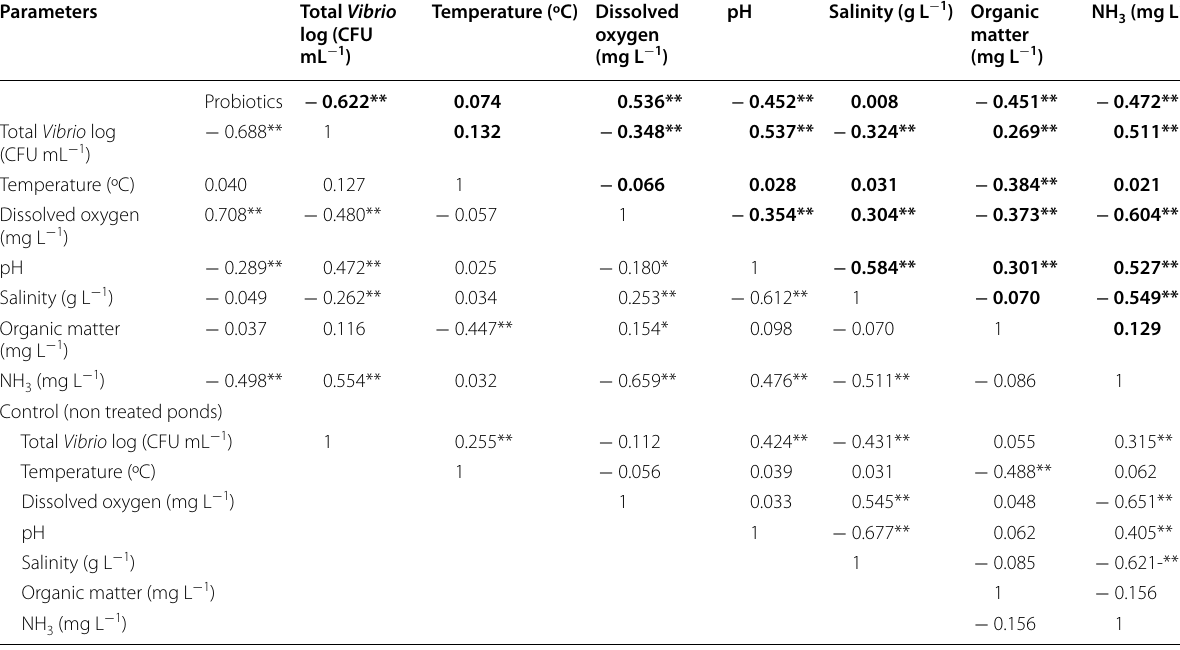
Probiotics: upper diagonal represents single spp. and lower one represents multi spp. *Correlation is significant at the 0.05 level (2-tailed) **Correlation is significant at the 0.01 level